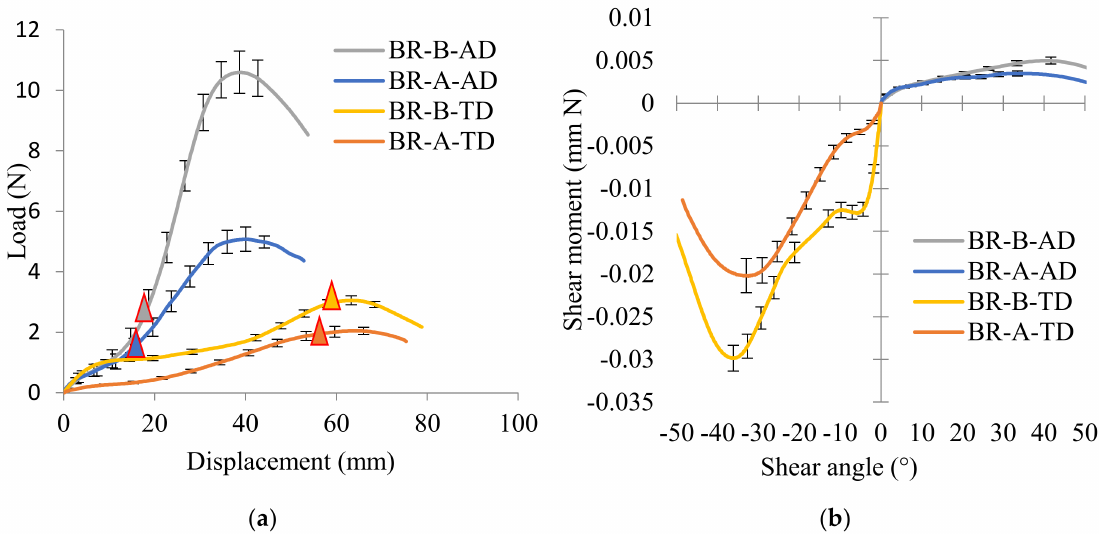
Figure 14. Influence of tow waviness and cover factor on thermal in-plane shear behavior: ( a ) load versus displacement curves, and ( b ) shear moments versus shear angle curves.